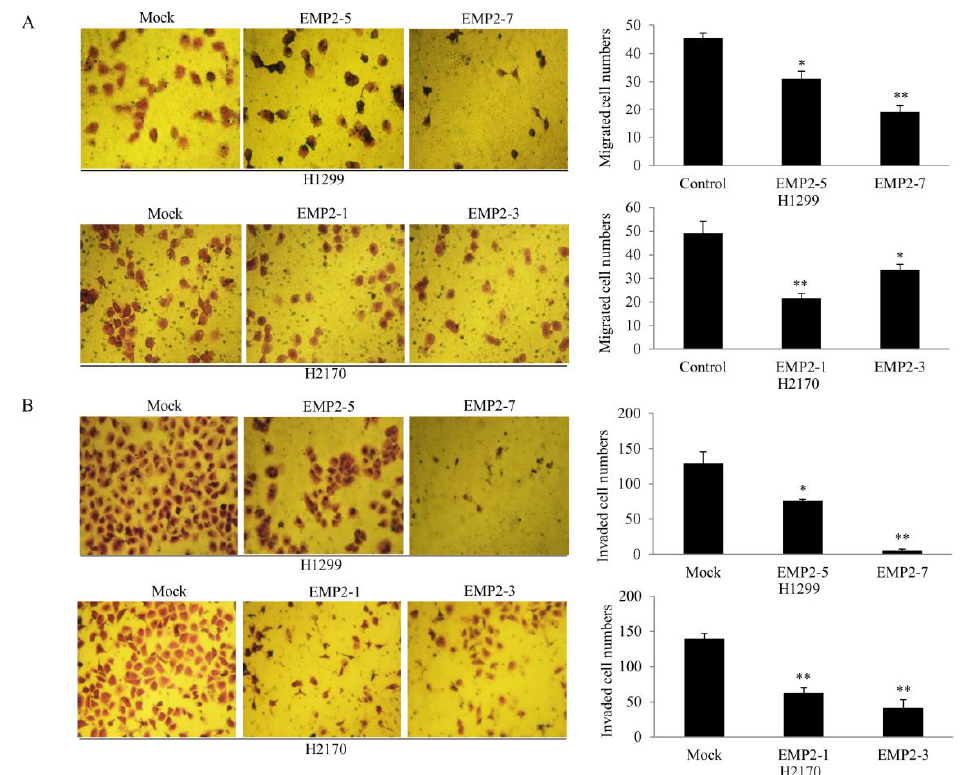
Figure 3. Effects of EMP2 overexpression on the migration and invasion of NSCLC cells. ( A ) Migration assay revealed that EMP2 suppressed migratory ability of the NSCLC cell lines H1299 and H2170 (40× objective). Quantification of cell migration (right). The data presented are the means ± SE from three independent experiments. ( B ) Invasion assay showed that EMP2 inhibited the invasive ability of NSCLC cells (40× objective). Quantification of invaded cells (right). The data presented are the means ± SE from three independent experiments. * p < 0.05 and ** p < 0.001 when analyzed with Student’s t -test.